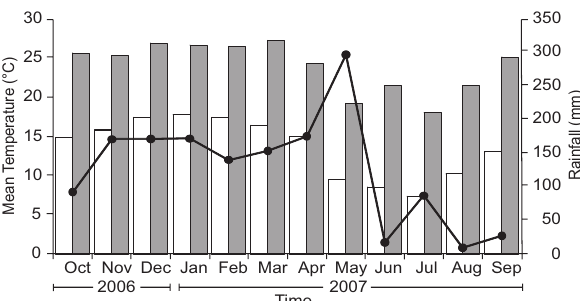
Figure 1. Monthly average minimum temperature (white bars), maximum temperature (black bars) and accumulated rainfall (line) at the study site from October 2006 to September 2007. Source: Instituto Agronômico do Paraná